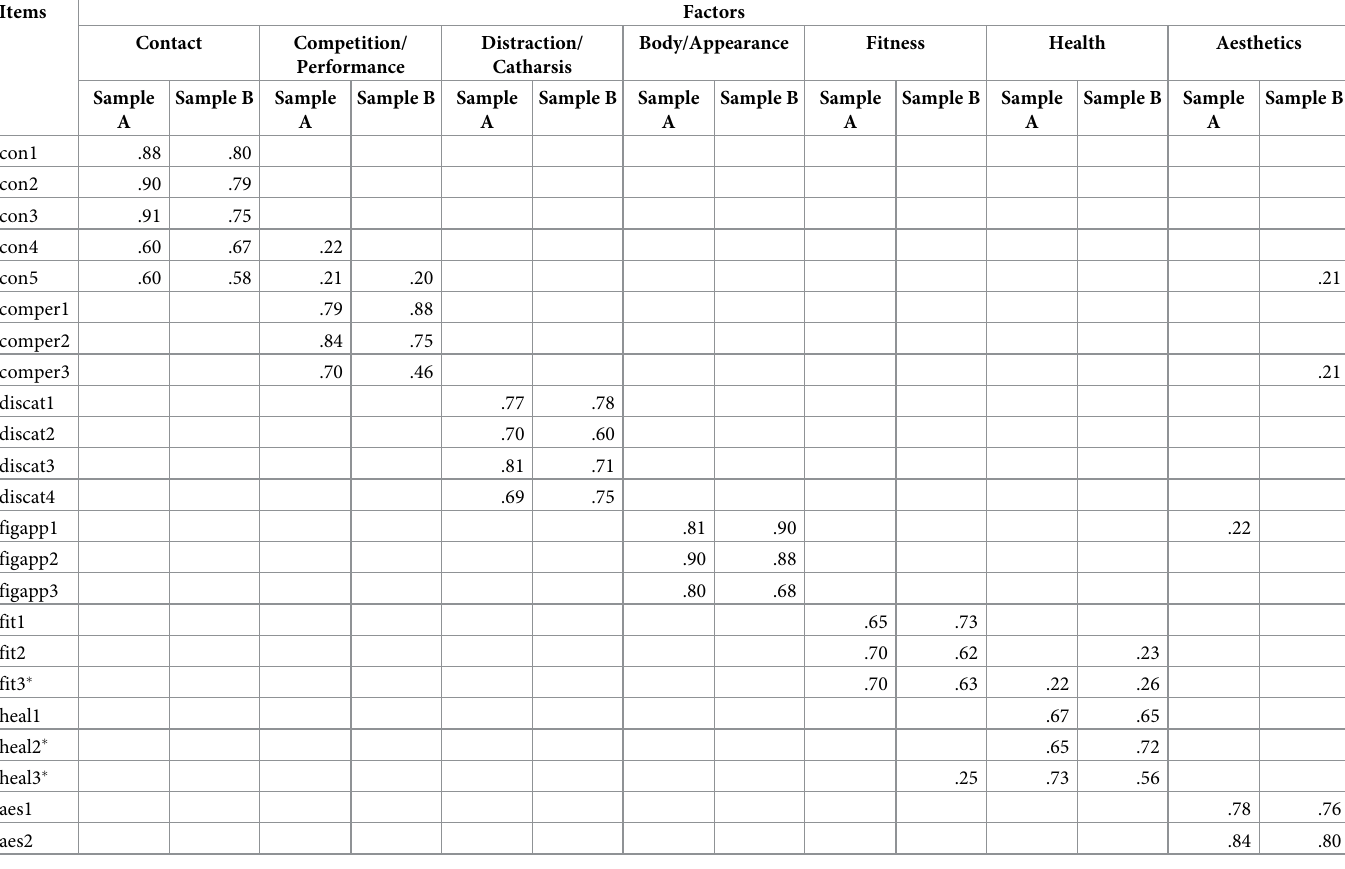
Table 5. Standardized factor loadings (ESEM) of the updated BMZI in sample A and